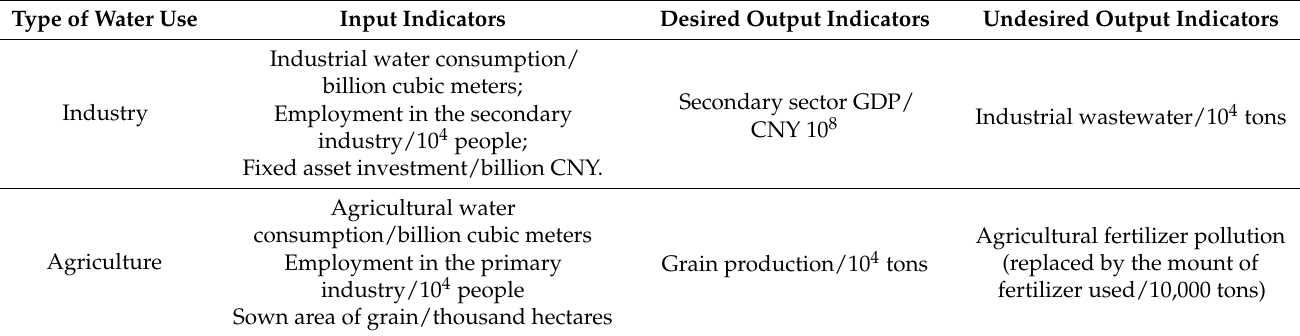
Table 1. Input and output indicators of the DEA model for water use